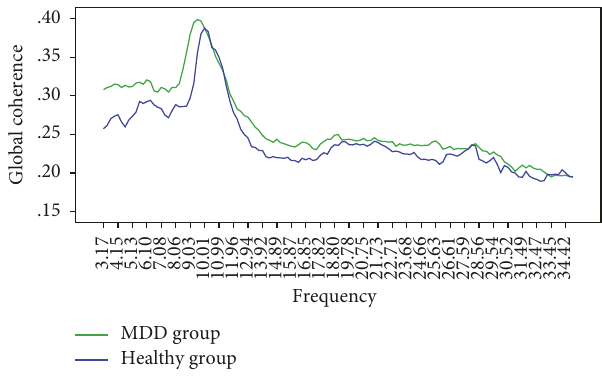
Figure 1: The coherence-frequency graph of MDD group and healthy group. The horizontal axis denoted the frequency and the vertical axis denoted the global coherence. There was the significant difference in the theta band (4–8 Hz). In alpha (8–13Hz) and beta bands (13–30 Hz), there was no diacritic difference in both